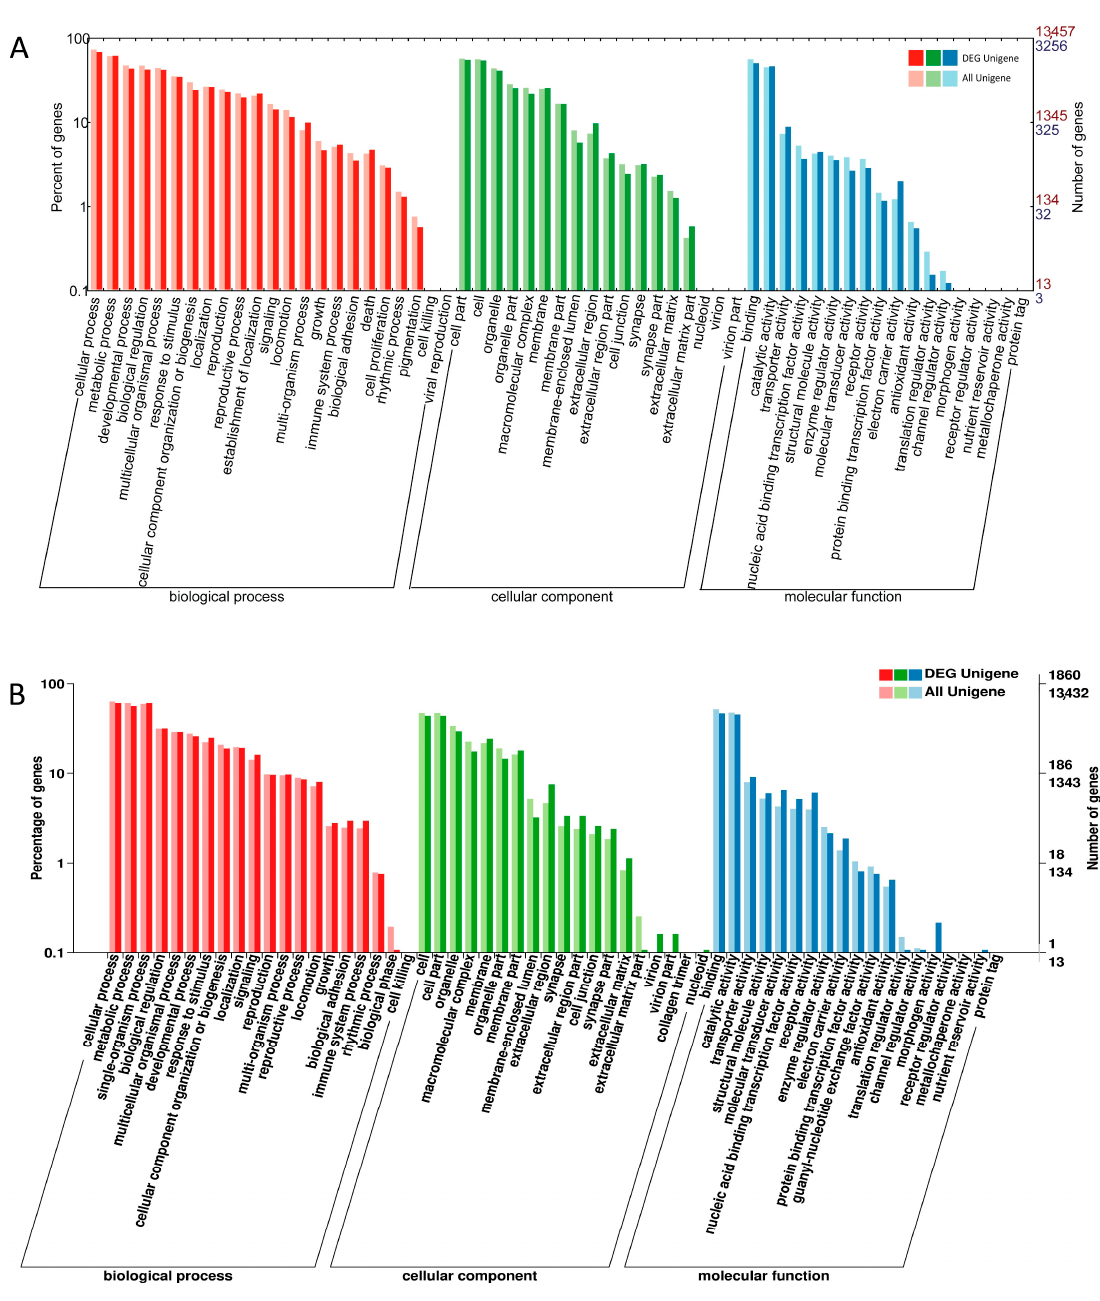
Figure 2. Cont. Figure 2.